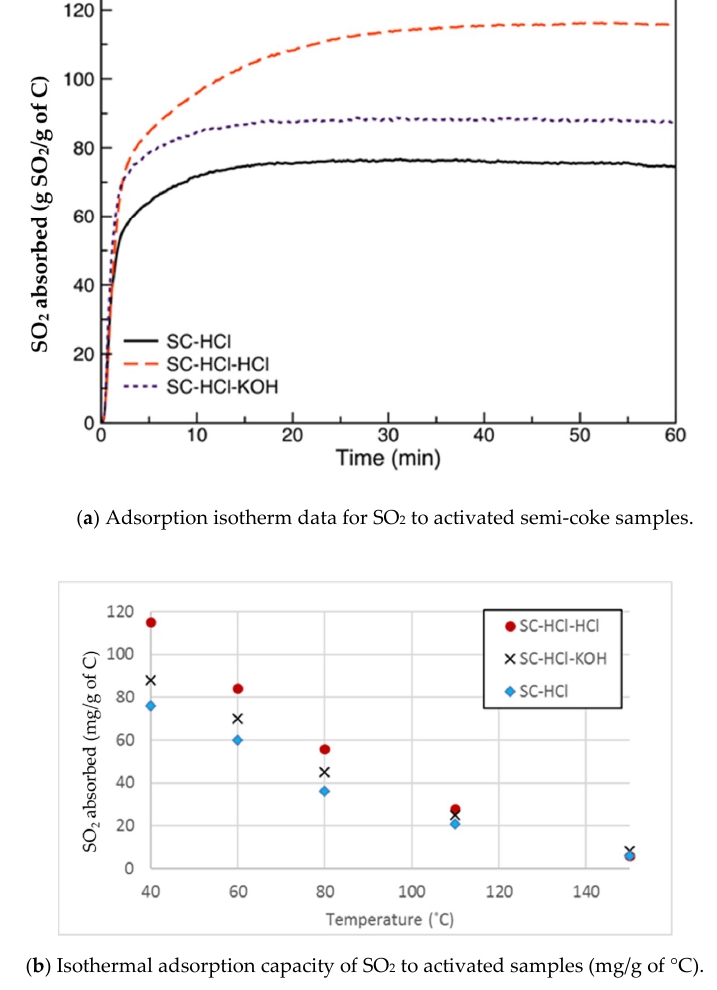
Figure 5. Isothermal adsorption of SO2 to activated semi-coke samples.